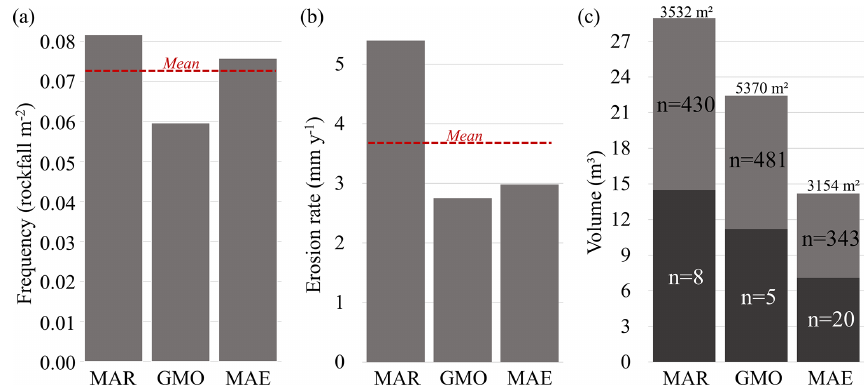
Figure 5. Mean annual rockfall frequency (a) , rockwall erosion rate (b) and total volume of rockfall for the overall studied period (c) .